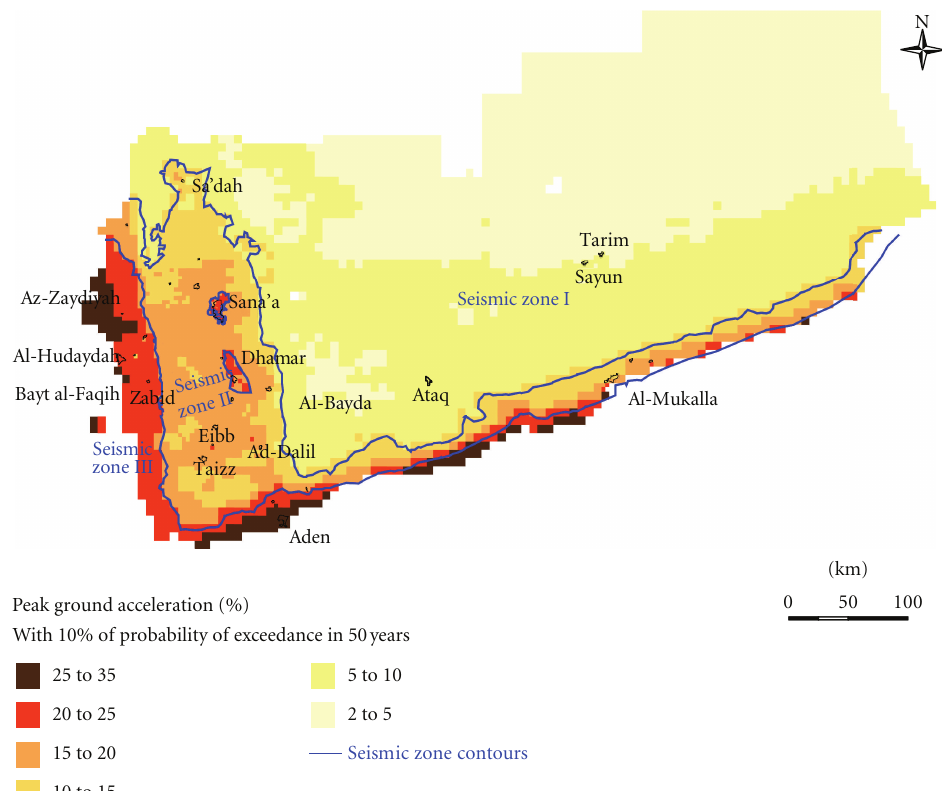
Figure 13: Seismic zoning in Yemen.